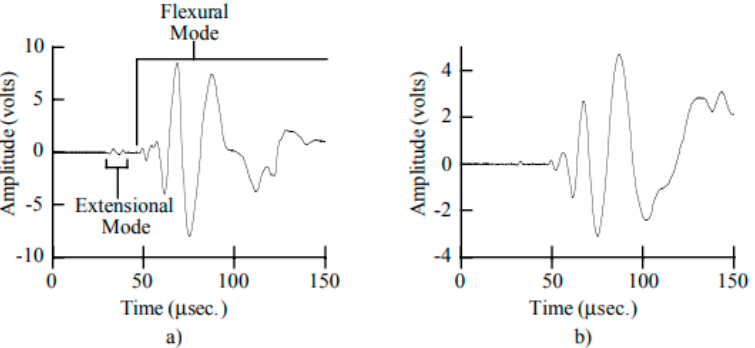
Figure 3. Signals generated by low-velocity impacts: ( a ) generated by a 5-times loaded compressed-air gun, ( b ) generated by a 2-times loaded compressed air gun [42].